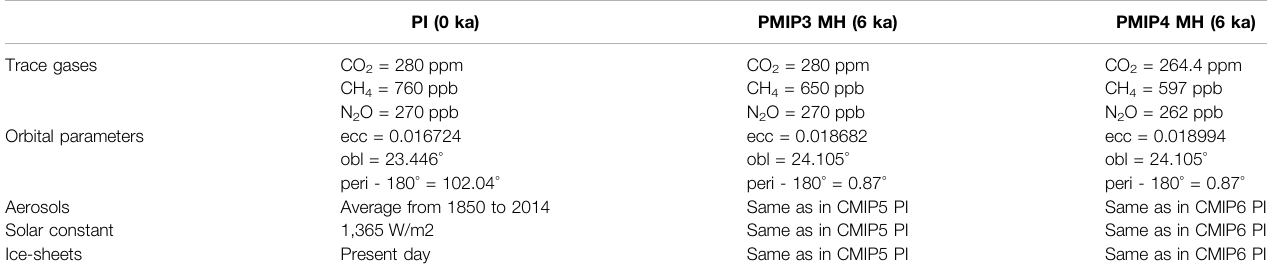
TABLE 2 | Model boundary conditions.